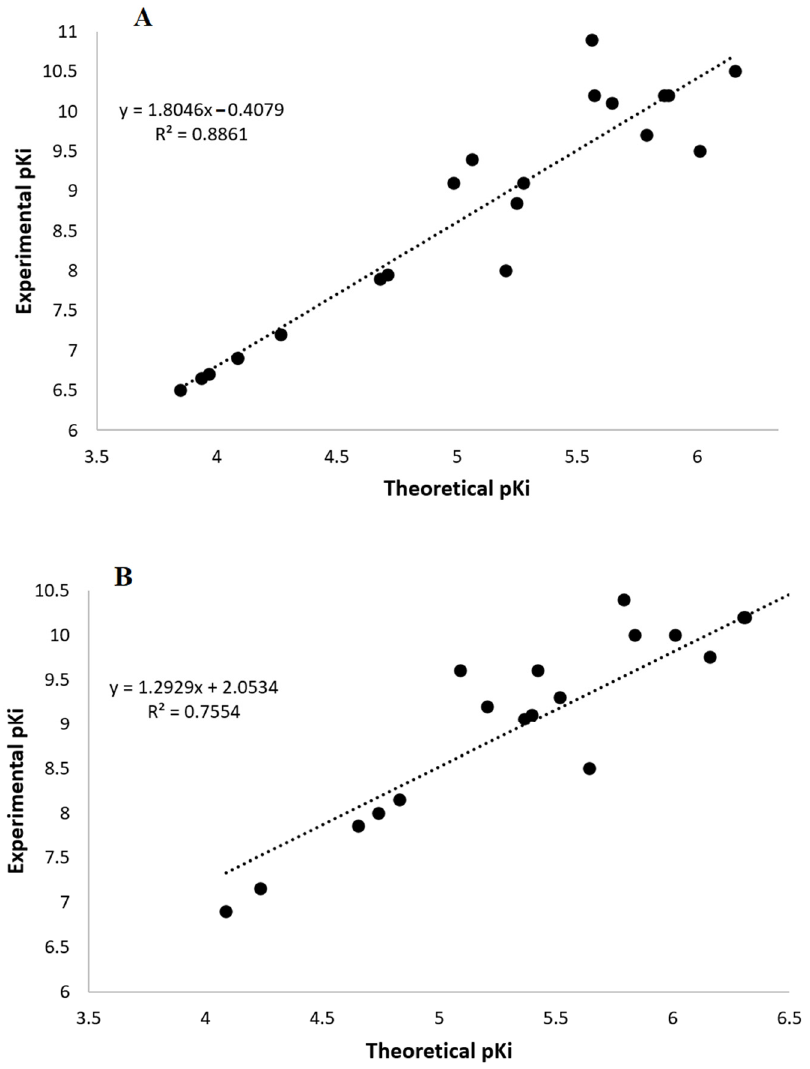
Figure 6. Relationship between estimated (theoretical) and reported (experimental) affinity of tested ligands on human MT1 ( A ) or MT2 ( B ) melatonin receptors. Linear regression equation and coeffi- cients of determination are shown in each plot.